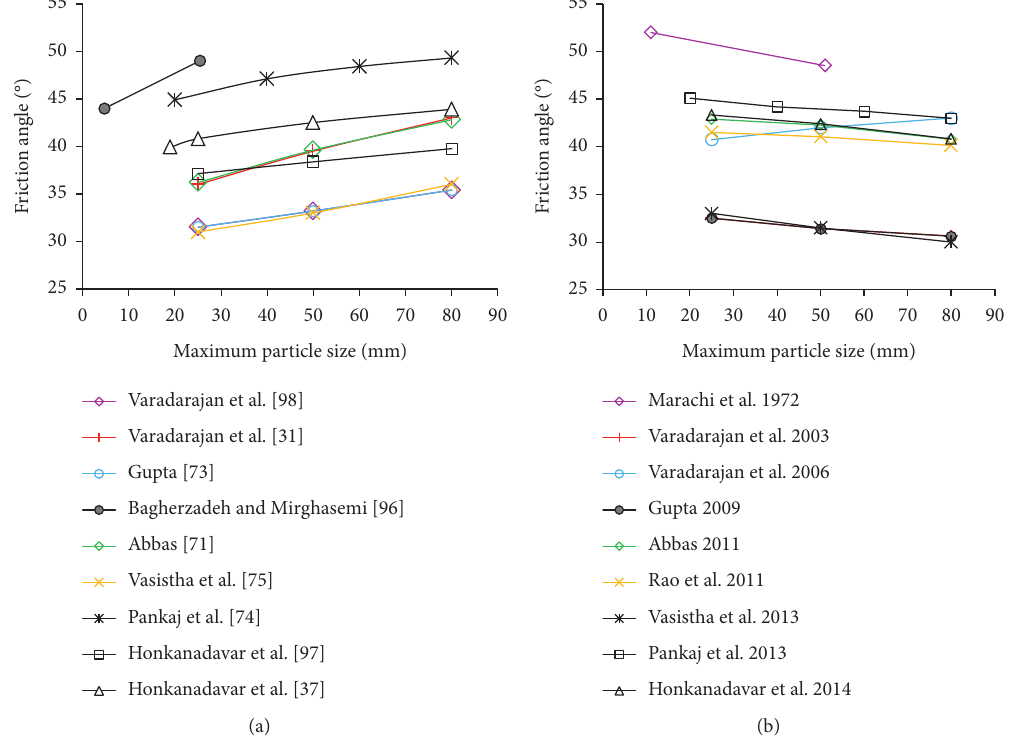
Figure 7: Variations of friction angle with maximum particle size for (a) rounded materials and (b) angular materials (data taken from